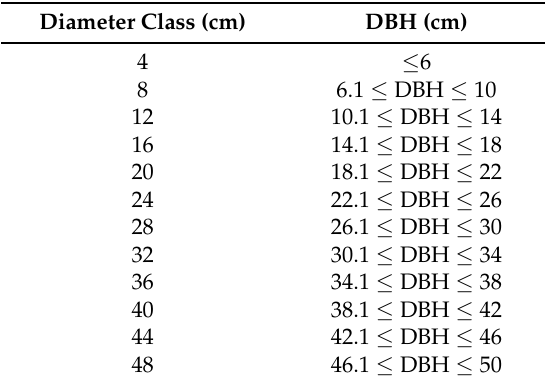
Table 4. Classification of diameter